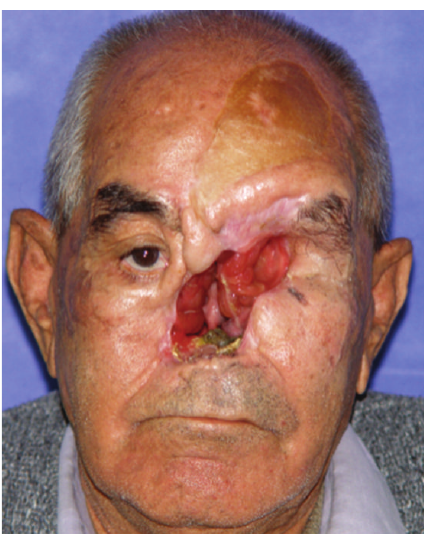
Figure 1: Midfacial defect after surgery.